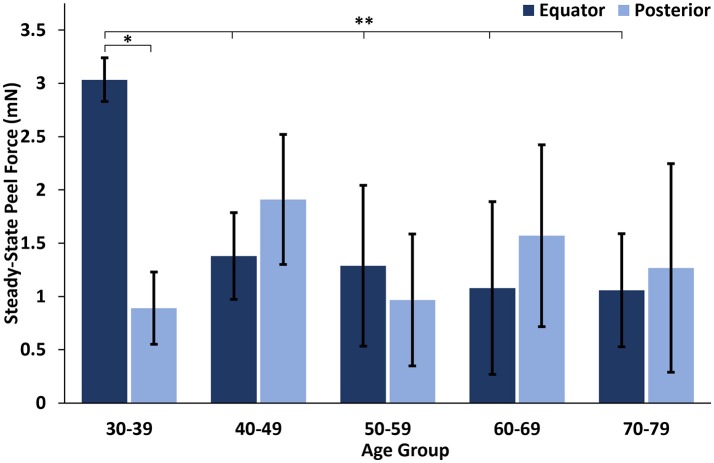
Steady-state peel force in the equator of the youngest human eyes was significantly greater than the posterior pole, and significantly greater than the equatorial steady-state adhesion of all other ages. Error bars indicate standard deviation from the mean. *p < 0.002 and **p < 0.015.